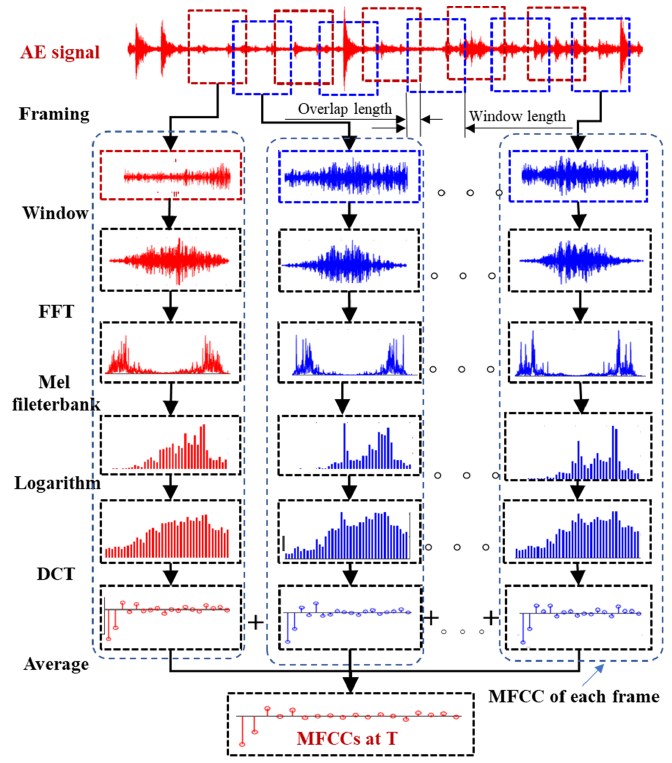
Figure 4. Extraction scheme of MFCC for the AE of coal [24].